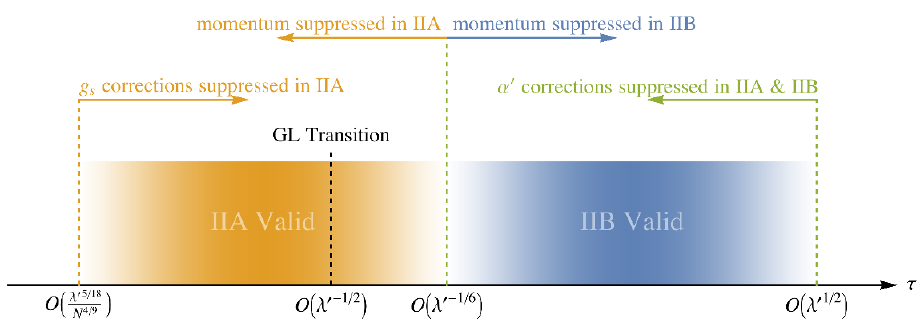
Figure 1 . Schematic regime of validity for IIA and IIB. Here, we take N 4 = 7 (cid:29) (cid:21) 0 (cid:29) 1, which is required for the GL transition to be visible within